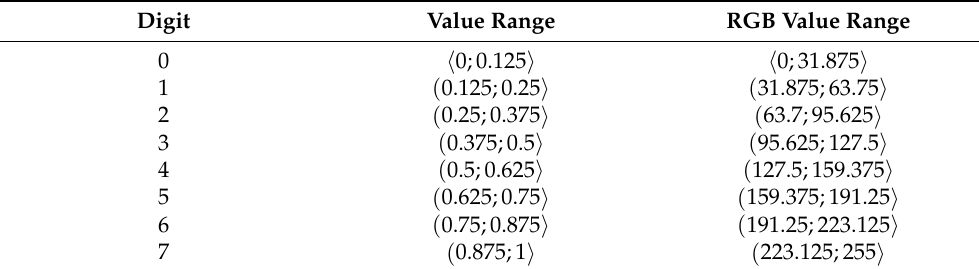
Table 1. Value ranges for encoding and decoding